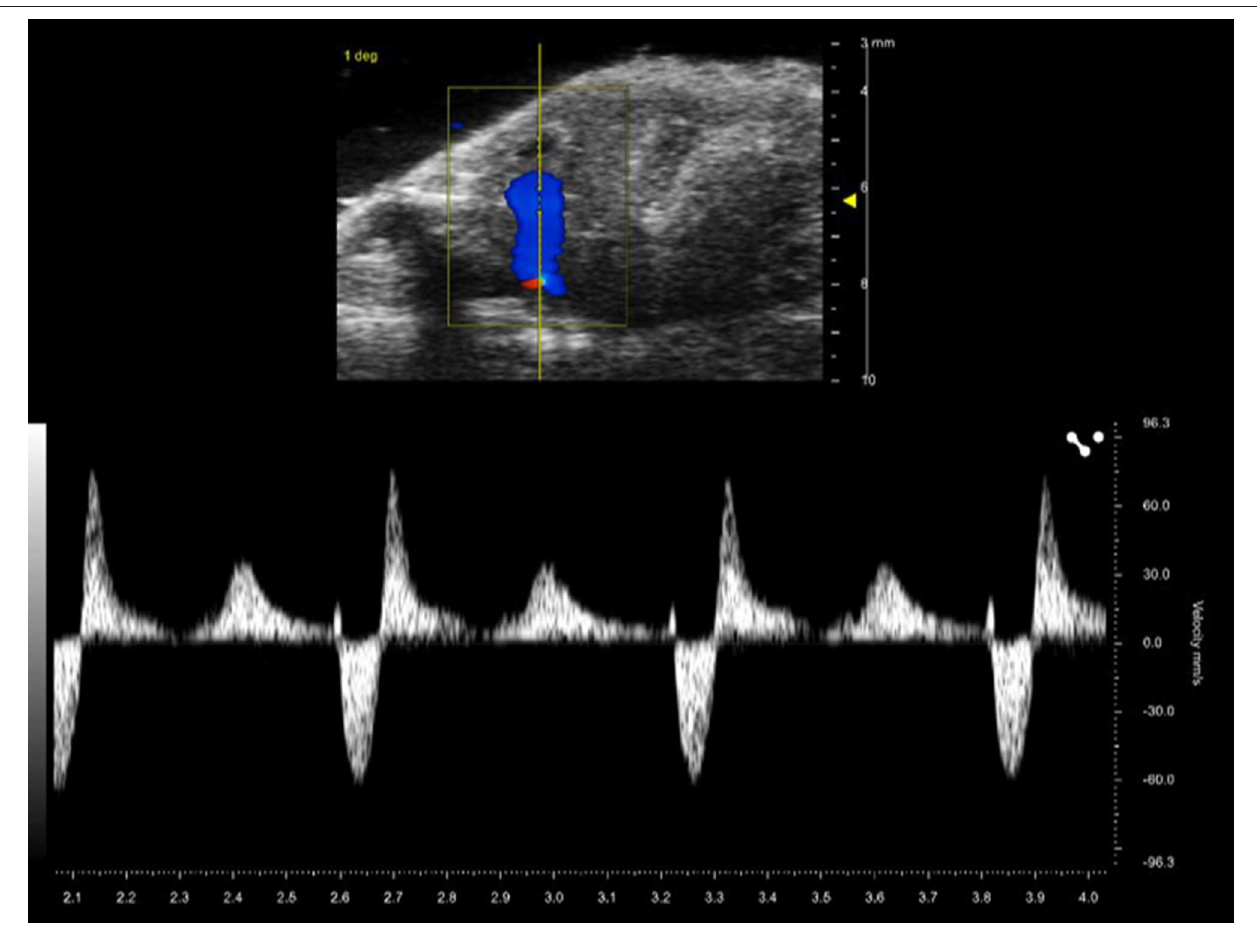
FIGURE 12 | Spectral and color Doppler (Duplex) image of adult zebrafish